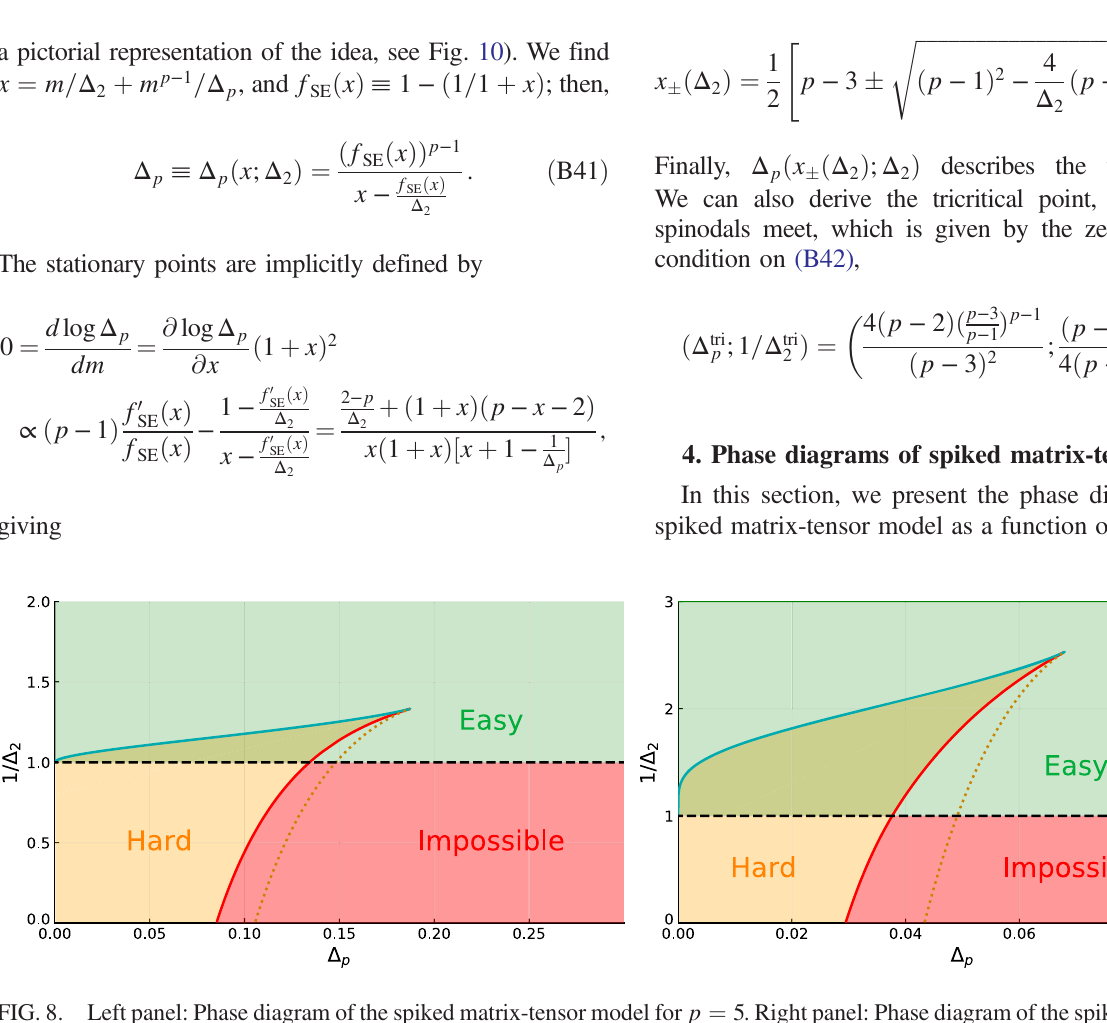
FIG. 7. Left panel: Phase diagram of the spiked matrix-tensor model for p ¼ 3 . The phase diagram identifies four regions: easy (green), impossible (red), and hard (orange). The lines correspond to different phase transitions, namely, the stability threshold (dashed black), the information-theoretic threshold (solid red), the algorithmic threshold (solid cyan), and the dynamical threshold (dotted orange). The vertical cuts represent the section along which the magnetization is plotted in Fig. 9. Right panel: Phase diagram of the spiked matrix-tensor model for p ¼ 4 . The main difference with respect to the case p ¼ 3 is that the algorithmic spinodal (solid cyan) is strictly above the stability threshold (dashed black). The hybrid-hard phase appears between these two lines (combined green and orange color). The vertical cuts represent the section along which the magnetization is plotted in Fig. 10.